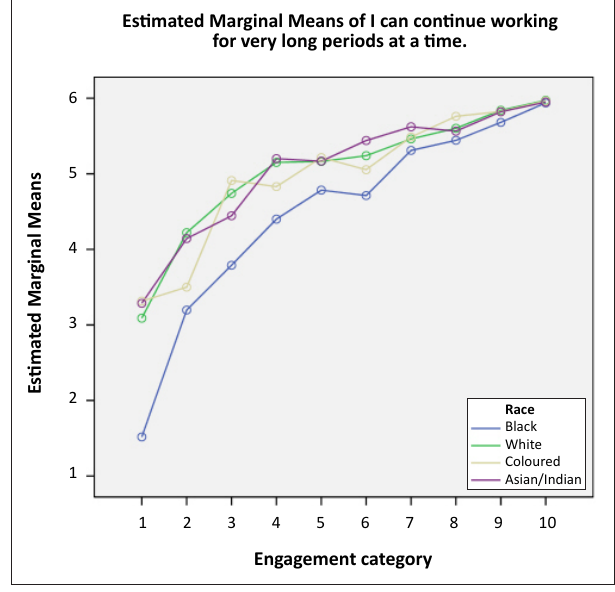
FIGURE 1: Race group mean differences in terms of engagement categories for item